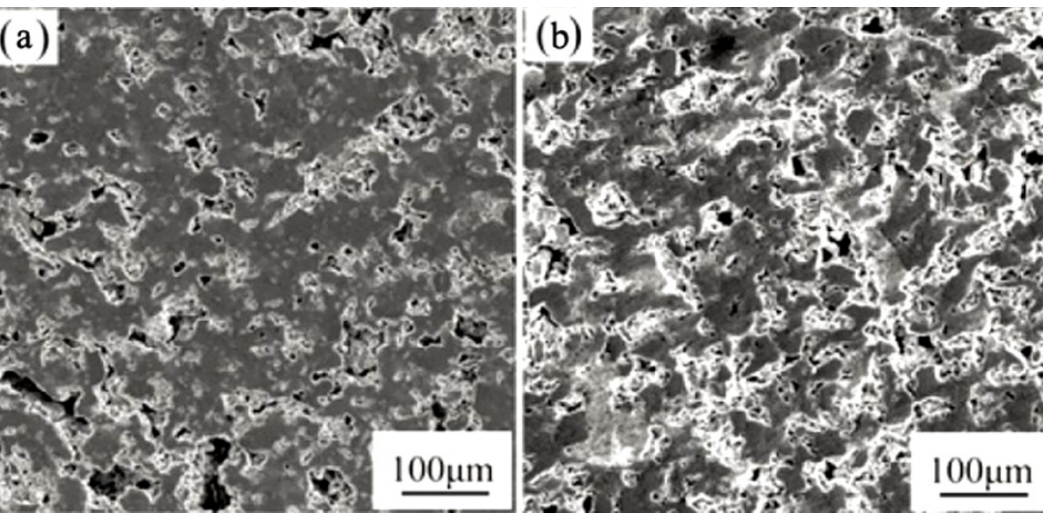
Figure 29. SEM microstructures of pore morphology and distribution in porous Ti-based alloys processed at 32% solid loading: ( a ) Ti-17.5Mo alloy; ( b ) Ti-35Nb alloy, respectively [307]. Reprinted with permission from [307]. Copyright 2012